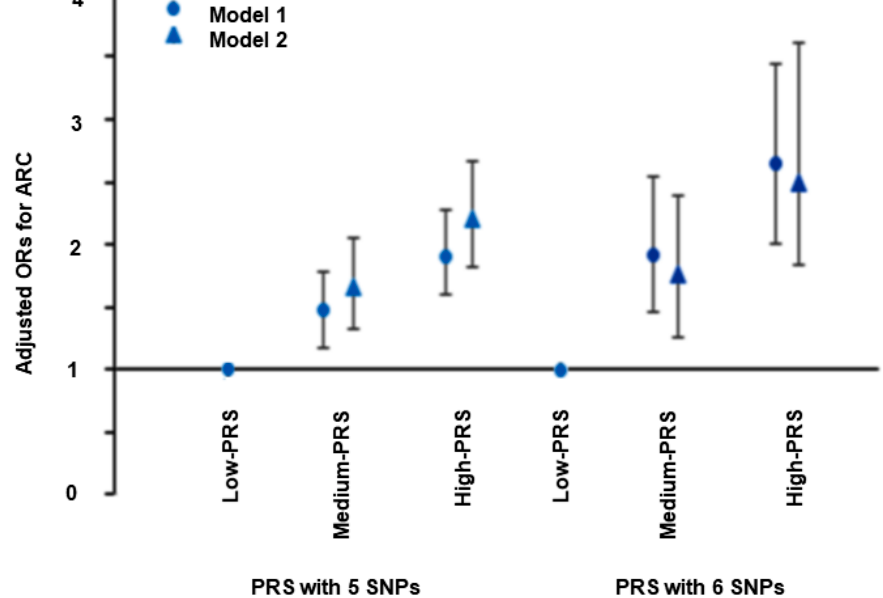
Figure 1. Adjusted odds ratios and 95% confidence intervals for age-related cataract (ARC) risk by polygenetic risk scores (PRS) using the 5 SNPs and 6 SNPs. PRS was calculated by the summation of polygenetic-risk scores of the best PRS model with 5 and 6 SNPs and categorized into three groups (0–6, 7–9, and ≥ 10) by the tertiles (low-PRS, medium-PRS, and high-PRS). They were adjusted with covariates for model 1, including age, gender, residence area, survey year, education, job, and income, for model 1 and covariates in model 2 containing for model 1 plus smoking, alcohol intake, physical activity, hypertension, serum glucose concentrations, HbA1c contents, energy intake, fat, protein and carbohydrate percent intake, and arthritis and dermatitis medicine intake for model 2.